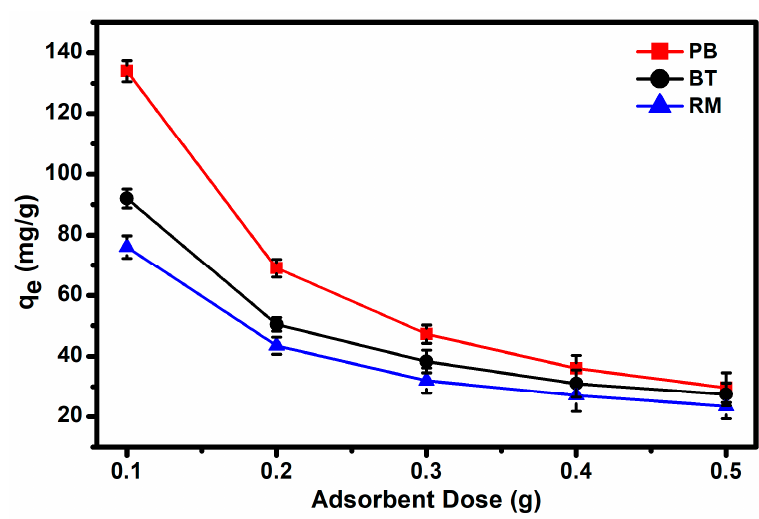
Figure 10. Effect of adsorbent dose on MG adsorption.